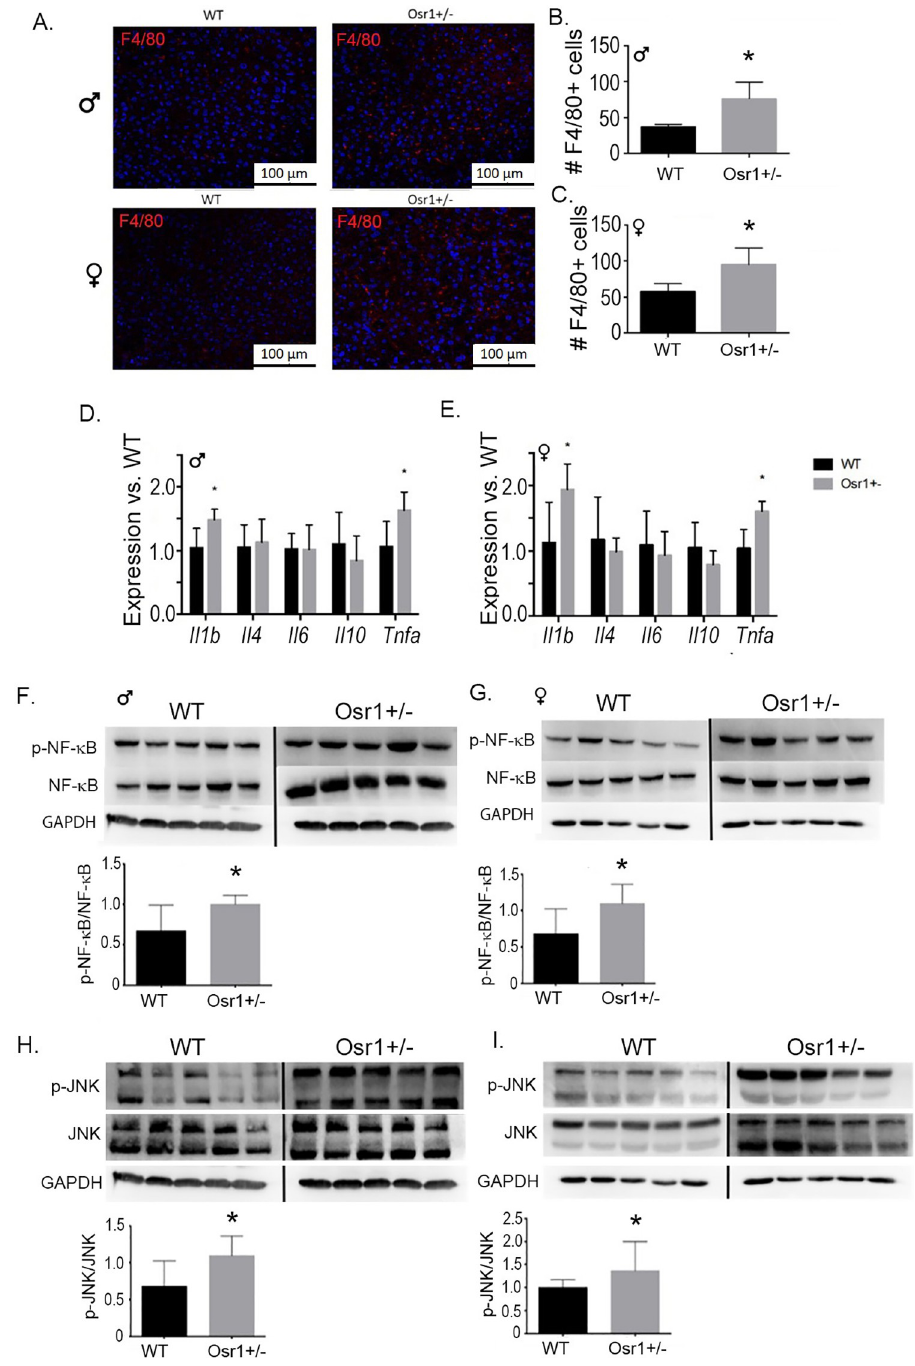
Fig 6. Osr1 heterozygous mice exhibited more liver inflammation in hepatic tissue. (A). F4/80 Immunofluorescence results for macrophages in hepatic tissue. Scale = 100 μ m. (B). Male mice F4/80 positive cell quantification. (C). F4/80 positive cell quantification in female mice. (D). Osr1 male mice exhibited significantly upregulated pro-inflammatory Il-1 β and TNF- α . (E). Osr1 female mice experienced significant upregulation of inflammokines Il-1 β and TNF- α . (F). Osr1male mice exhibited significantly upregulated pNF- κ B/NF- κ B compared to male WT mice. (G). Osr1 female mice experienced significant upregulation of pNF- κ B/NF- κ B. (H). pJNK/JNK was significantly increased in Osr1 heterozygous males. (I). Osr1 heterozygous females displayed significant upregulation of pJNK/JNK signaling compared to WT female mice.